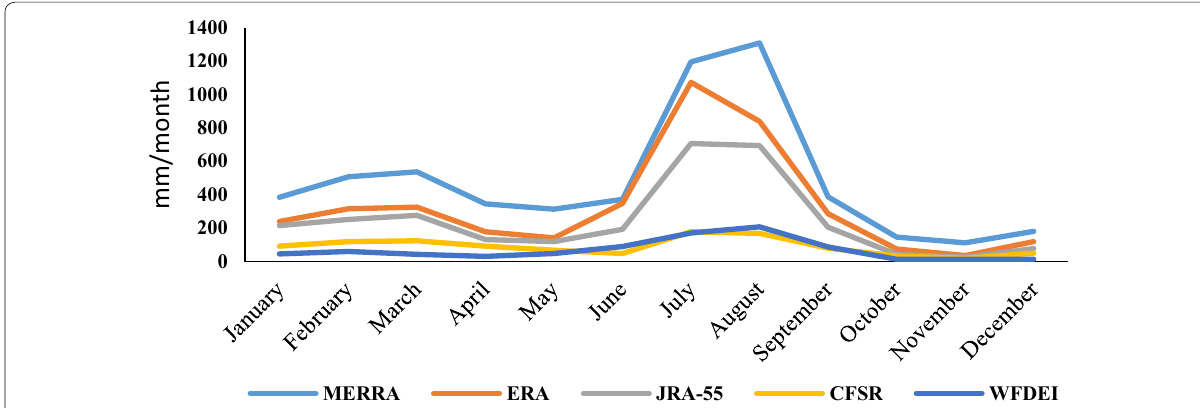
Fig.13 Monthly average rainfall for five climatic dataset for the Beas river basin for time period